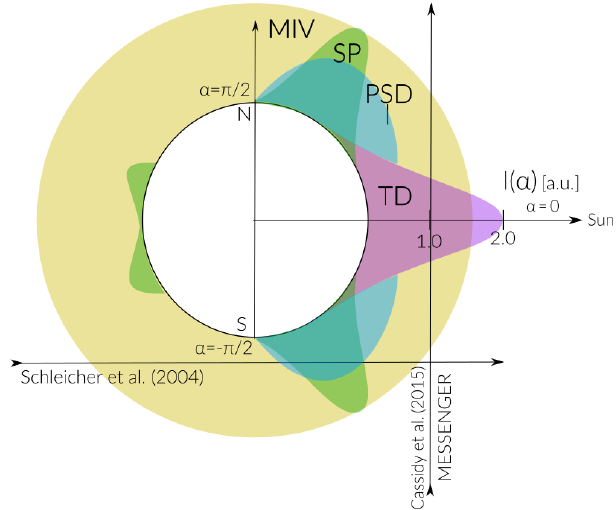
Figure 6. Scheme of the intensity distributions for the different re- lease mechanisms as a function of solar zenith angle. The units are arbitrary, but orders of magnitude are taken from the results of our model. The horizontal arrow is an example of the line of sight of the ground-based observations by Schleicher et al. (2004). Vertical arrow represents the approximate direction of MESSENGER’s field of view during observations on 23 April 2012 (Cassidy et al.,